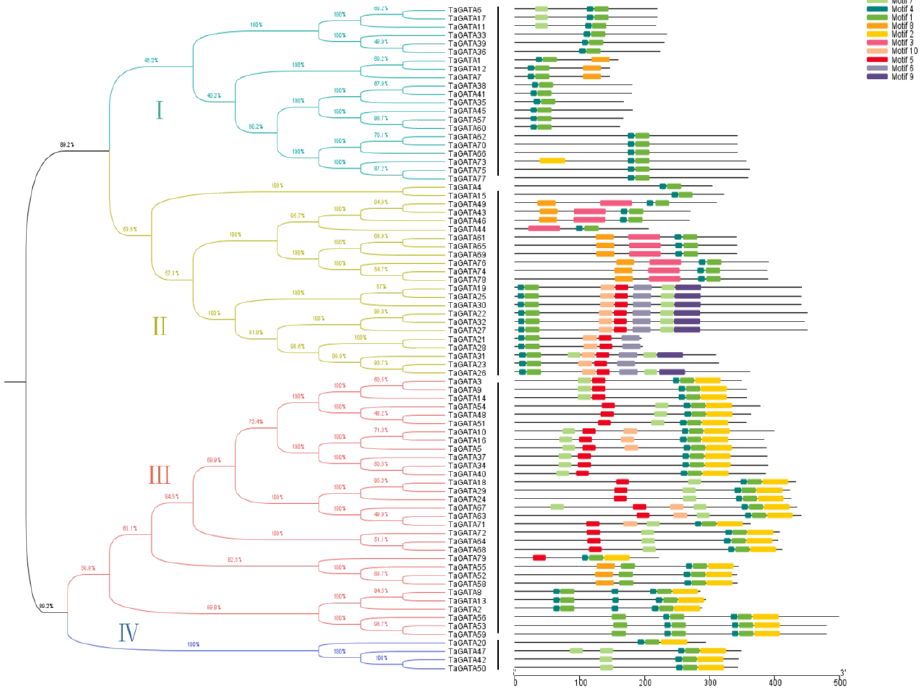
Figure 2. The motif structure analysis of TaGATA proteins. Four subfamilies of TaGATAs classified with MEGA6 software. The protein length (number of amino acid residues) displayed at the bottom.